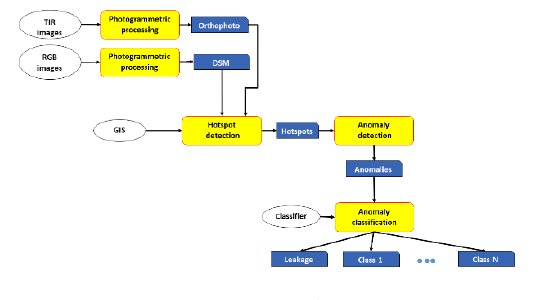
Figure 1 System